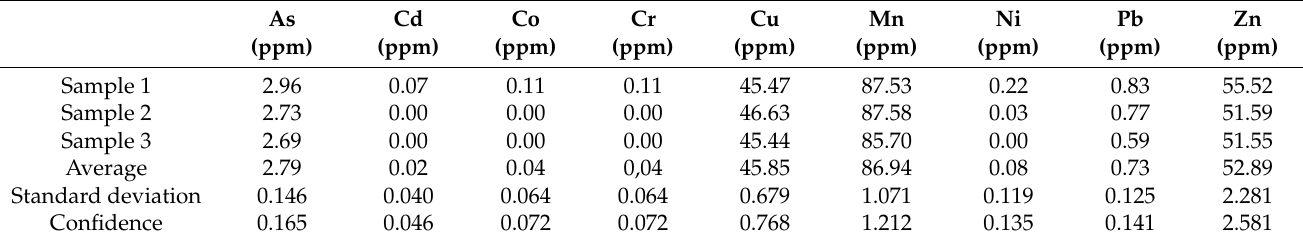
Table 10. Determination of the content of minor elements in carbonized samples of vine